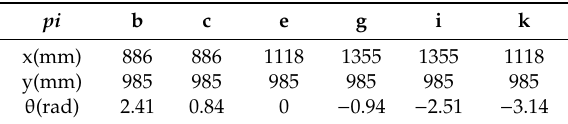
Table 1. The actual measured values of mobile robot.